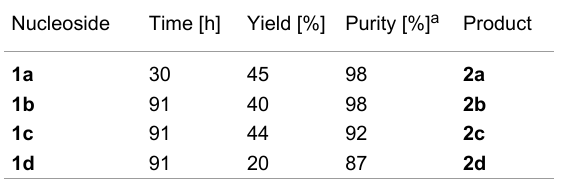
Table 1: Reaction times, yields and purities of